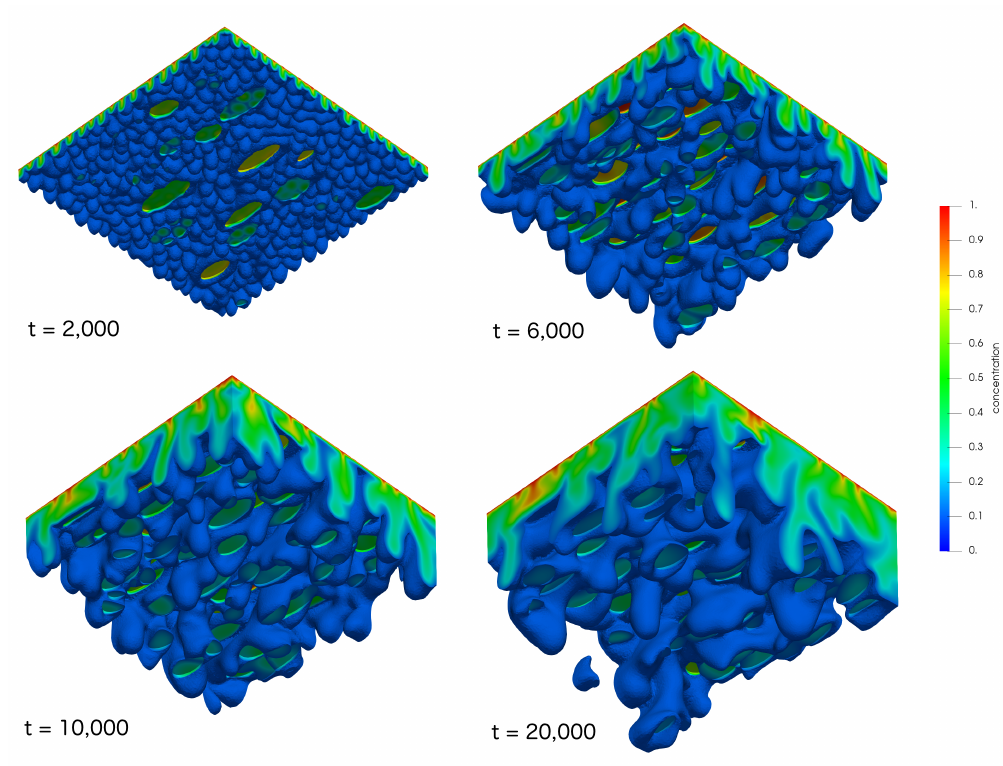
Figure 7. Evolution of convective mixing in heterogeneous model with elliptical barriers. Barrier distribution shown in Figure 3. Only concentrations greater than 0.1 are shown. Barriers are removed from the figure. Time is dimensionless.